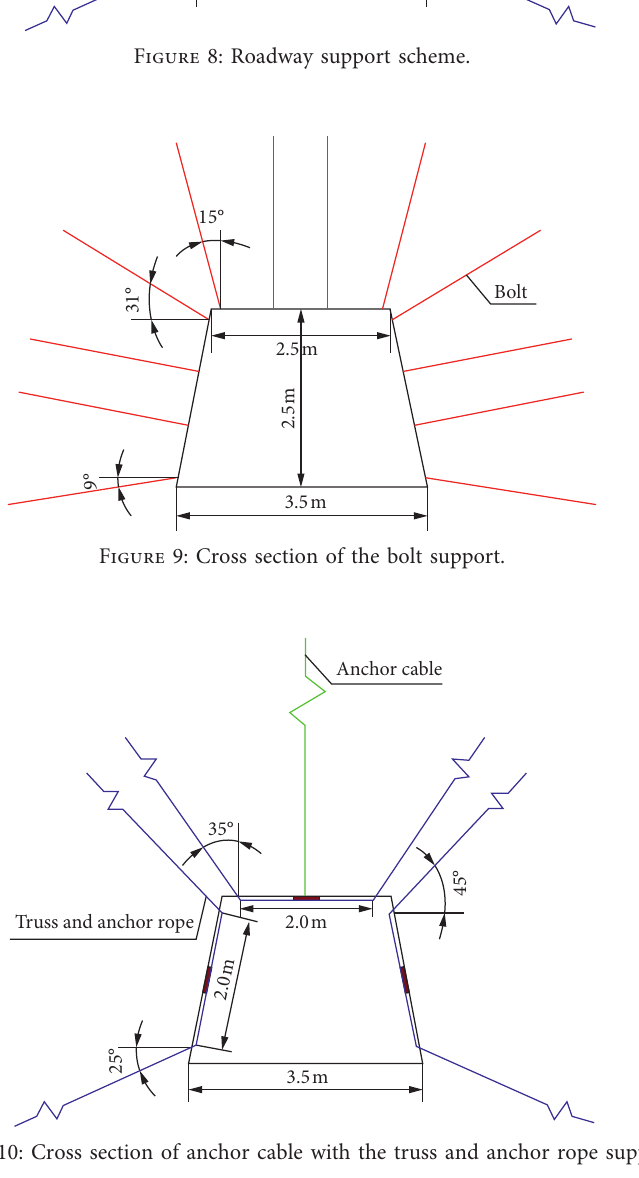
Figure 8: Roadway support scheme.